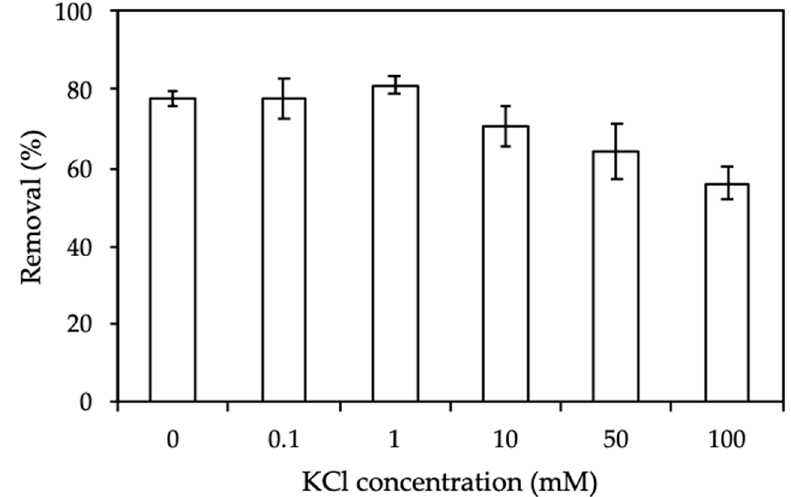
Figure 10. Effect of ionic strength on removal of CFX using protein-modified nanosilica (ProMNS). ( C i (CFX) = 20 mg/L, pH 7.0, adsorption time 90 min, adsorbent dosage 10 mg/mL). Error bars show standard deviations of three replicates.